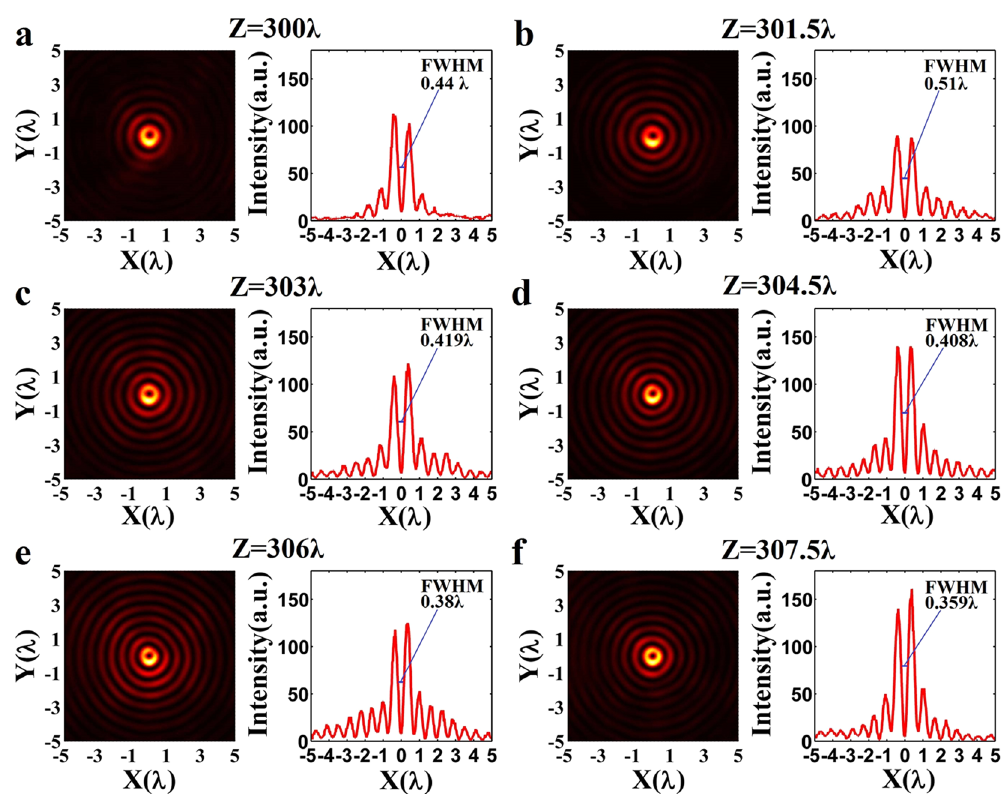
Figure 7. Experimental obtained optical intensity in the designed range of the optical hollow needle. ( a ) – ( f ) The color maps of 2-dimentional transverse optical intensity distributions on the XY plane and the transverse optical intensities along the x-axis obtained at different propagation distances of 300 λ , 301.5 λ , 303 λ , 304.5 λ , 306 λ , and 307.5 λ , respectively, where the optical intensity is plotted in arbitrary unit. The corresponding FWHM of the central hollow ring is 0.44 λ , 0.51 λ , 0.419 λ , 0.408 λ , 0.38 λ , and 0.359 λ ,